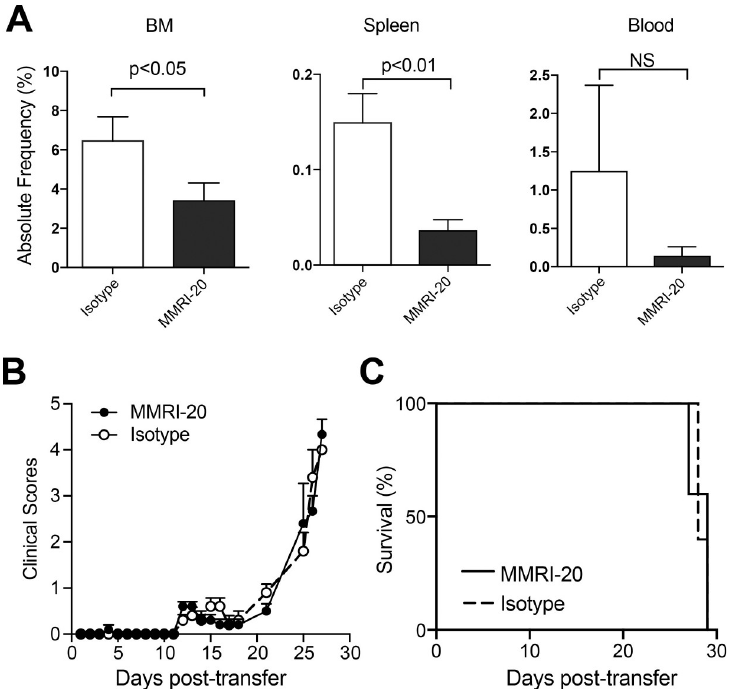
Fig 3. Ex vivo MMRI-20 binding reduces engraftment of leukemic cell lines HL-60 in NOD/SCID mice. (A) Bar graphs showing absolute frequency of HL-60 cells coated with MMRI-20 or isotype control mAb in BM, spleen and blood of NOD/SCID mice 21 days after iv injection (n = 6/group). HL-60 cells were identified as human CD33 + , human CD45 + , mouse CD45 - cells in tissue cell suspensions by flow cytometry (see panel B of S1 Fig). (B) Disease scores and (C) survival curves of five NOD/SCID mice injected with MMRI-20 or isotype control mAb coated HL-60